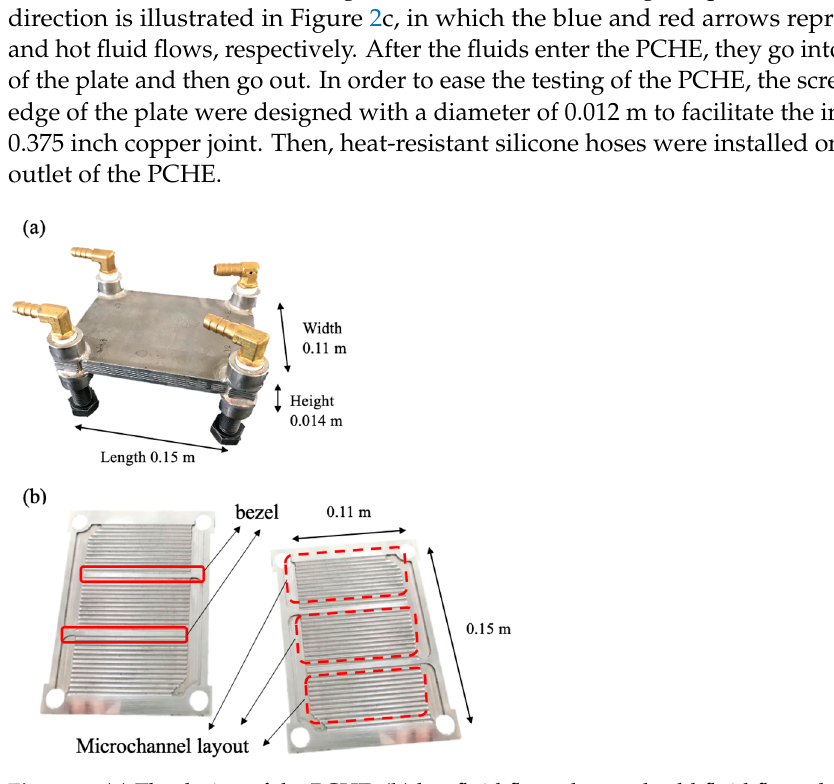
Figure 2. Flow plate geometric of PCHE and flow direction: ( a ) cold and hot fluid flow plate; ( b ) side view and three-dimensional explosion map; and ( c ) schematic diagram of the PCHE. 2.2. Experiment Setup The experimental apparatus and setup to measure and calculate the thermal perfor- mance of the PCHE is described in Figure 3, which consists of water as the hot and cold working fluids, two flow meters (Shuang Huan, Taiwan, DK800-6) with adjustable valves installed on the hot fluid and cold fluid circulating loop, refrigerated circulating bath (Yih Der, Tainan, Taiwan, BL710-D), pump (HITON, Tainan, Taiwan, HF-8006) and a 40-L wa- ter heating system powered by liquified petroleum gas (Ta-Han, Tainan, Taiwan, BDF- 23C). The temperatures were measured using eight K-type thermocouples (Chuan Yu,